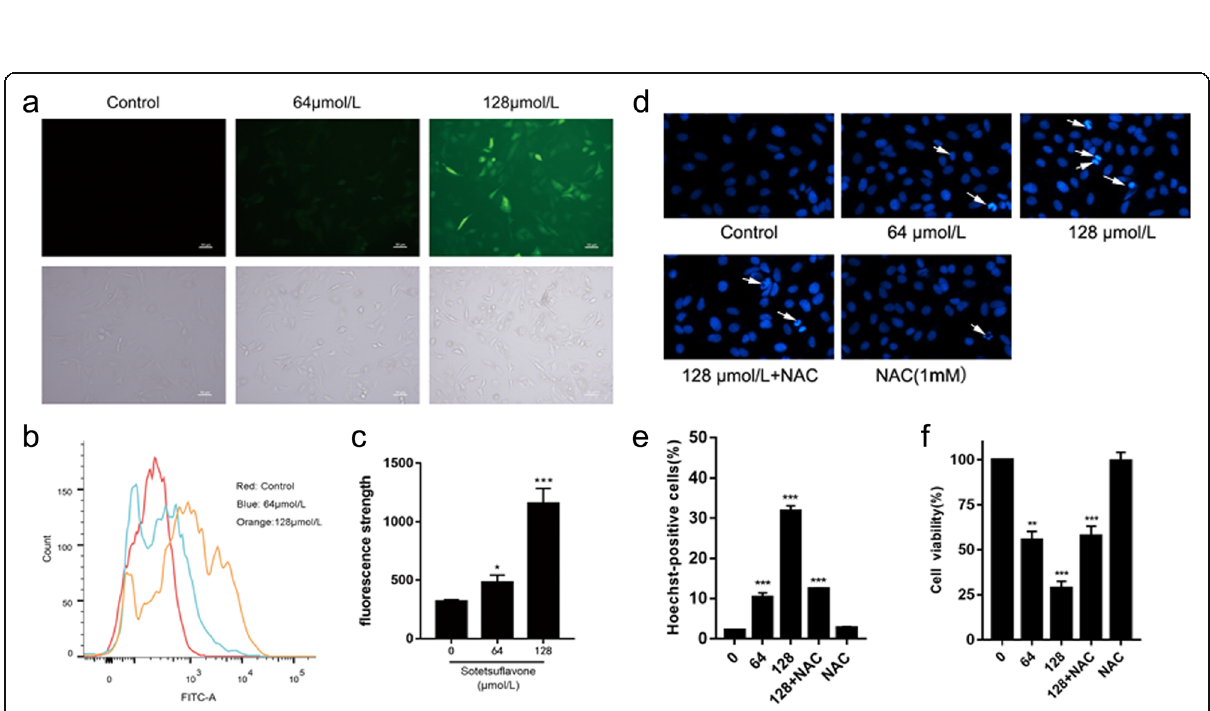
Fig. 4 Determination of reactive oxygen species in A549 cells by sotetsuflavone. a Fluorescence image analysis of sotetsuflavone inducing apoptosis in A549 cells stained by DCFH-DA(100 × magnification). b Average fluorescence intensity of ROS was analyzed by flow cytometry after DCFH-DA staining. c Effect of sotetsuflavone on reactive oxygen species in A549 cells. d , e The experiment was divided into five groups, which were respectively added with 0, 64, 128, 128, 0 μ mol/L sotetsuflavone, then, 10 mM NAC solution was added in groups 4 and 5, respectively, thereby became 0(control), 64, 128, 128+NAC and NAC groups. and the images of fluorescent microscopic analysis sotetsuflavone and NAC respectively inducing apoptosis in A549 cells stained with hoechst 33,258 staining. f The experimental group was the same as Fig. 4d, e. and the result showed that inhibitory effect of sotetsuflavone on proliferation of A549 cells. The results from three independent experiments were expressed as mean±SD compared with the control group, * P <0.01, *** P <0.001